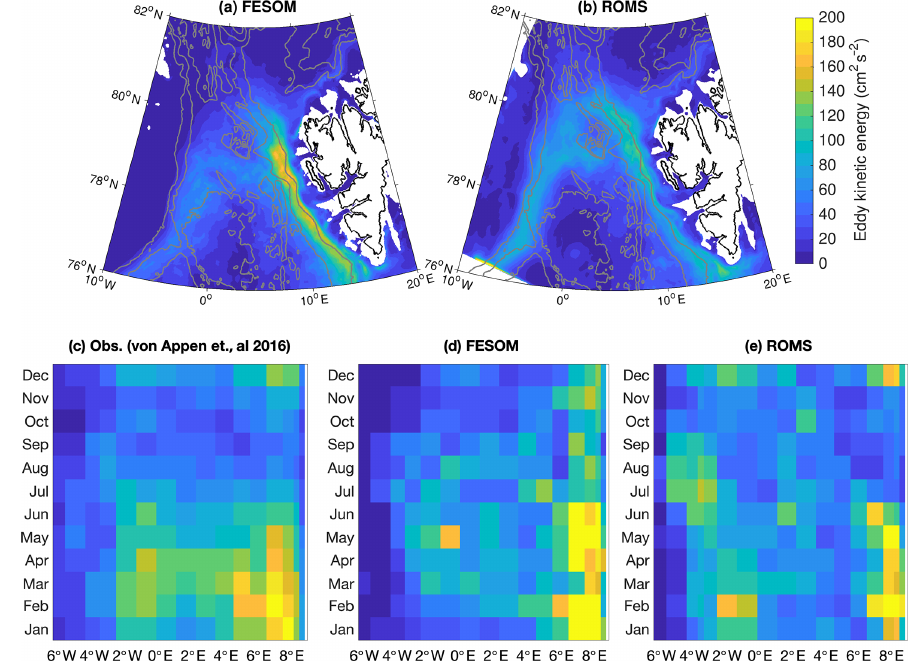
Figure 5. Eddy kinetic energy (EKE). (a, b) Maps of EKE at a depth of 100m from (a) FESOM and (b) ROMS for the years 2006–2009. Grey contour lines indicate bathymetry at 1000m intervals. (c–e) Seasonal cycle of EKE at a depth of 75m across Fram Strait at 78 ◦ 50 (cid:48) N from (c) mooring measurements (von Appen et al., 2019), (d) FESOM and (e) ROMS for the years